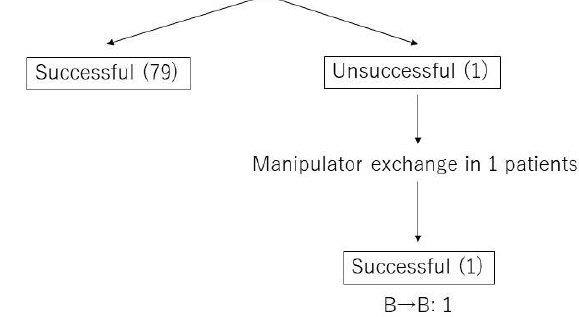
Figure 2. Flowchart of the procedural details including GW and / or manipulator exchange in common bile duct (CBD) stone removal cases.Experience level of GW manipulator; B was defined as five years or more but less than 10 years. One case succeeded by manipulator exchange from the experience level B to the experience level B.